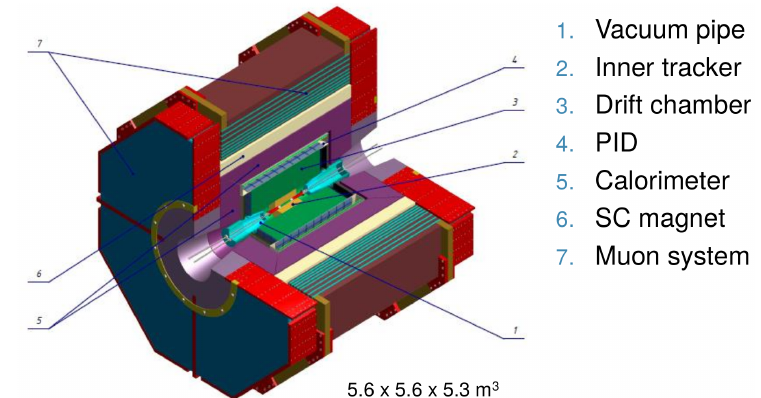
Figure 1. Novosibirsk Super Charm-Tau Factory Detector.